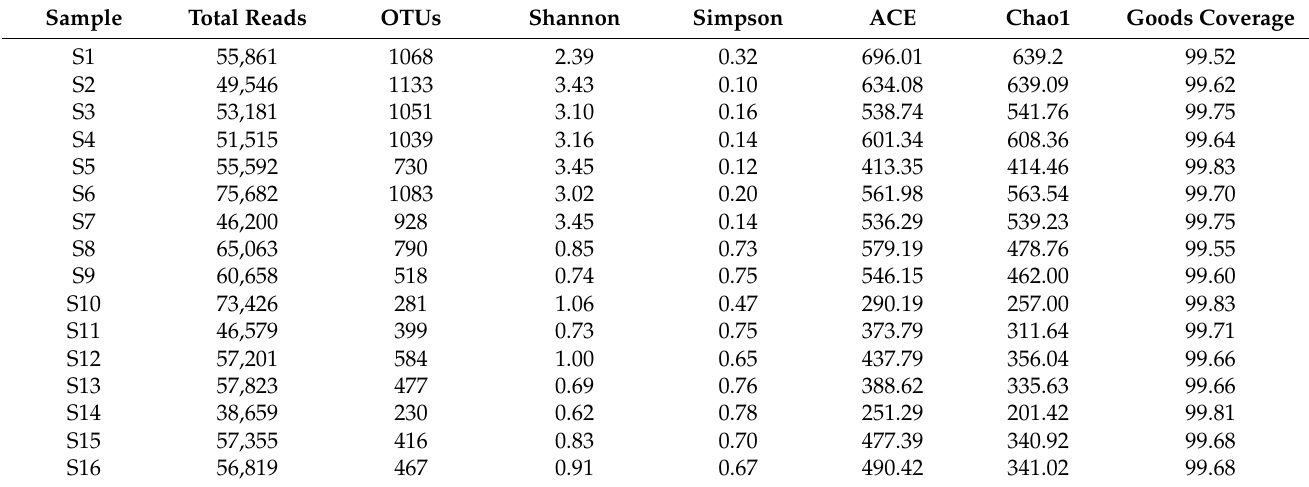
Abbreviations: OTUs, operational taxonomic